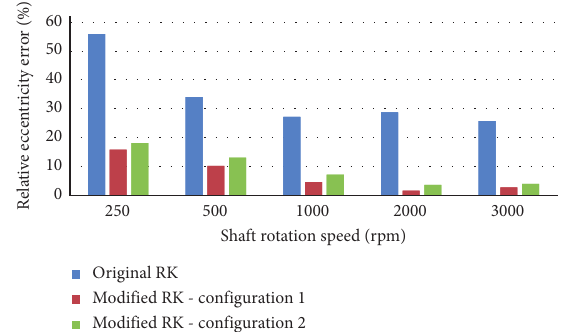
Figure 13: Difference between measured and 2D correlation model relative eccentricities for different test rigs.